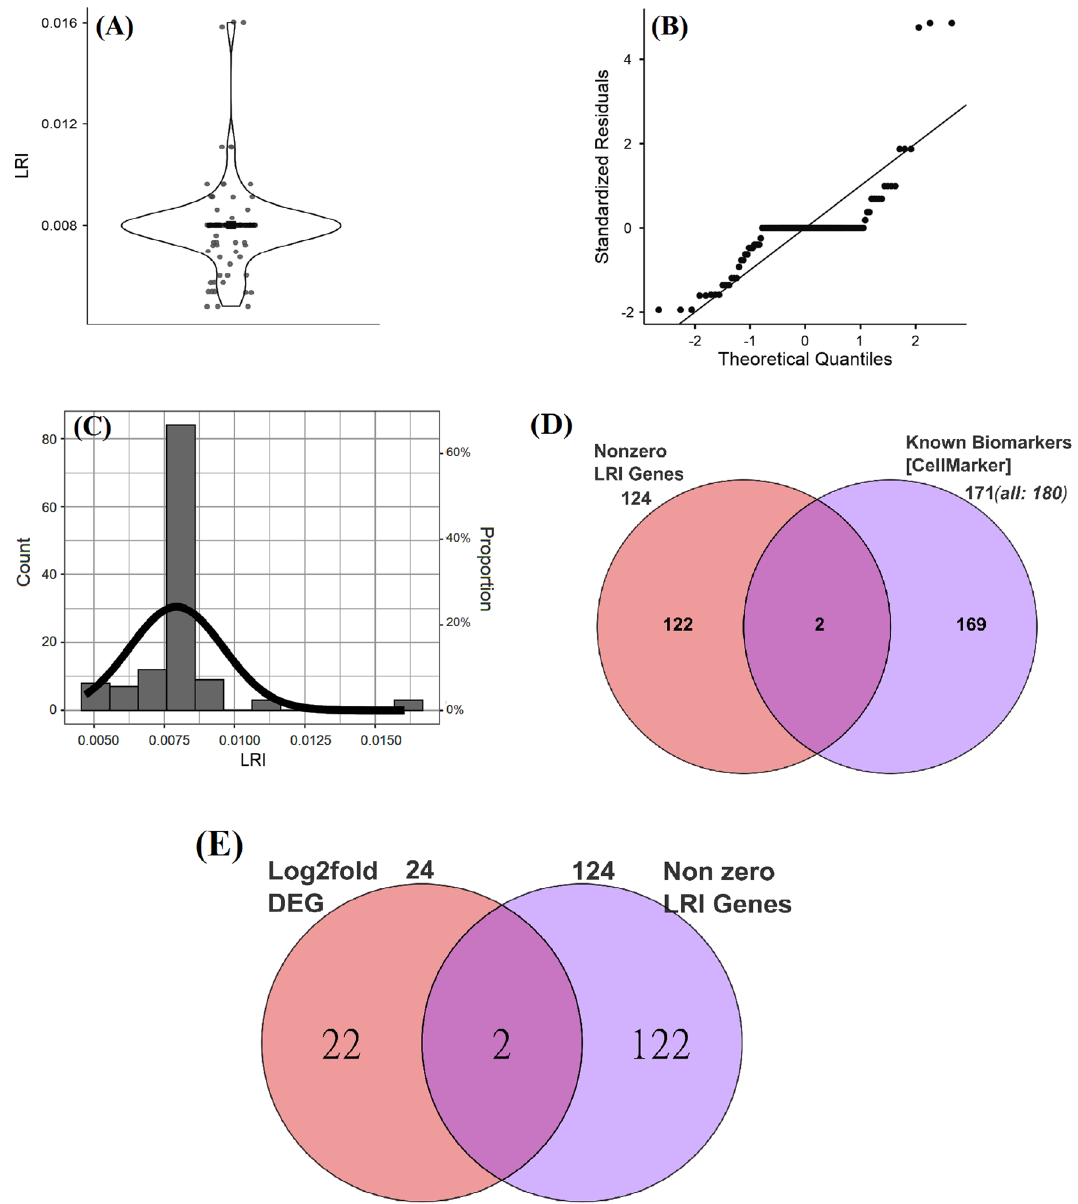
Figure 1. Distribution of LRI values of the salient genes. The figure exhibits the distribution of 126 salient genes. Violin plot ( A ) with jittered points data points and mean value, Q–Q plot ( B ) and histogram combined density plot ( C ) to show distribution LRI values of these 126 salient genes. ( D ) Comparison of the 124 salient genes (out of 126 Gene IDs, two Gene IDs did not map to Entrez ID) with 171 (after removing duplicates from the total 180 genes) unique cancer biomarkers from CellMarker database exhibits overlap of only two genes and 122 genes exhibits uniqueness. ( E ) Comparison of the 124 salient genes with 24 DEGs of CRC exhibits overlap of only two